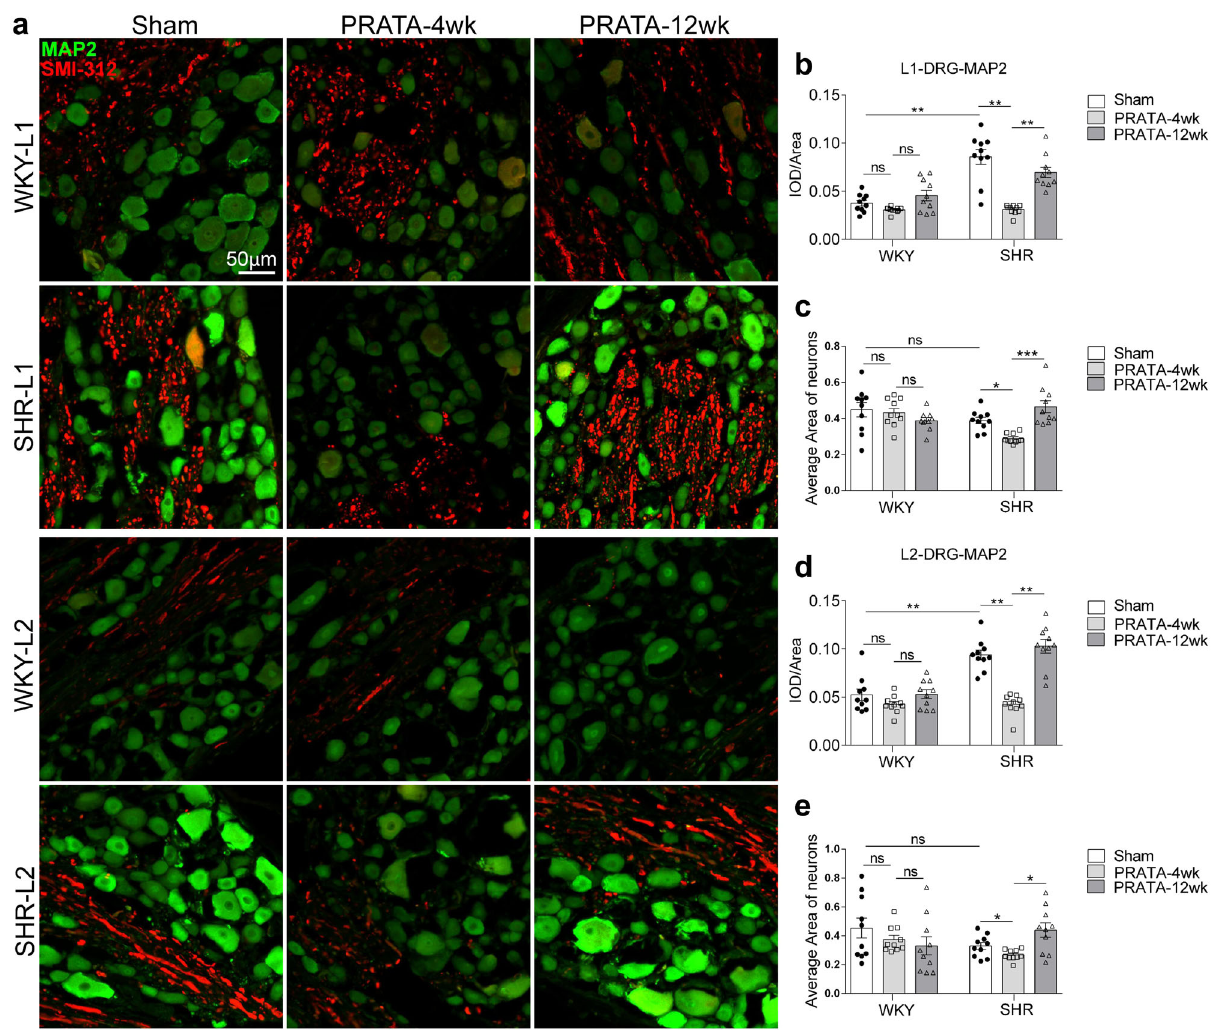
Fig. 5 PRATA promotes L1-L2 DRG neuron remodeling. a – e Imaging of central and peripheral axons by immunostaining of MAP2 and SMI-312 in L1-L2 DRG ( a ), scale bar = 50 μ m; and quanti fi cation ( b – e ). n = 10 per group, Data are mean ± SEM. Non-signi fi cant (ns) P > 0.05, * P < 0.05, ** P < 0.01, *** P < 0.001. ANOVA, Bonferroni post-hoc test,